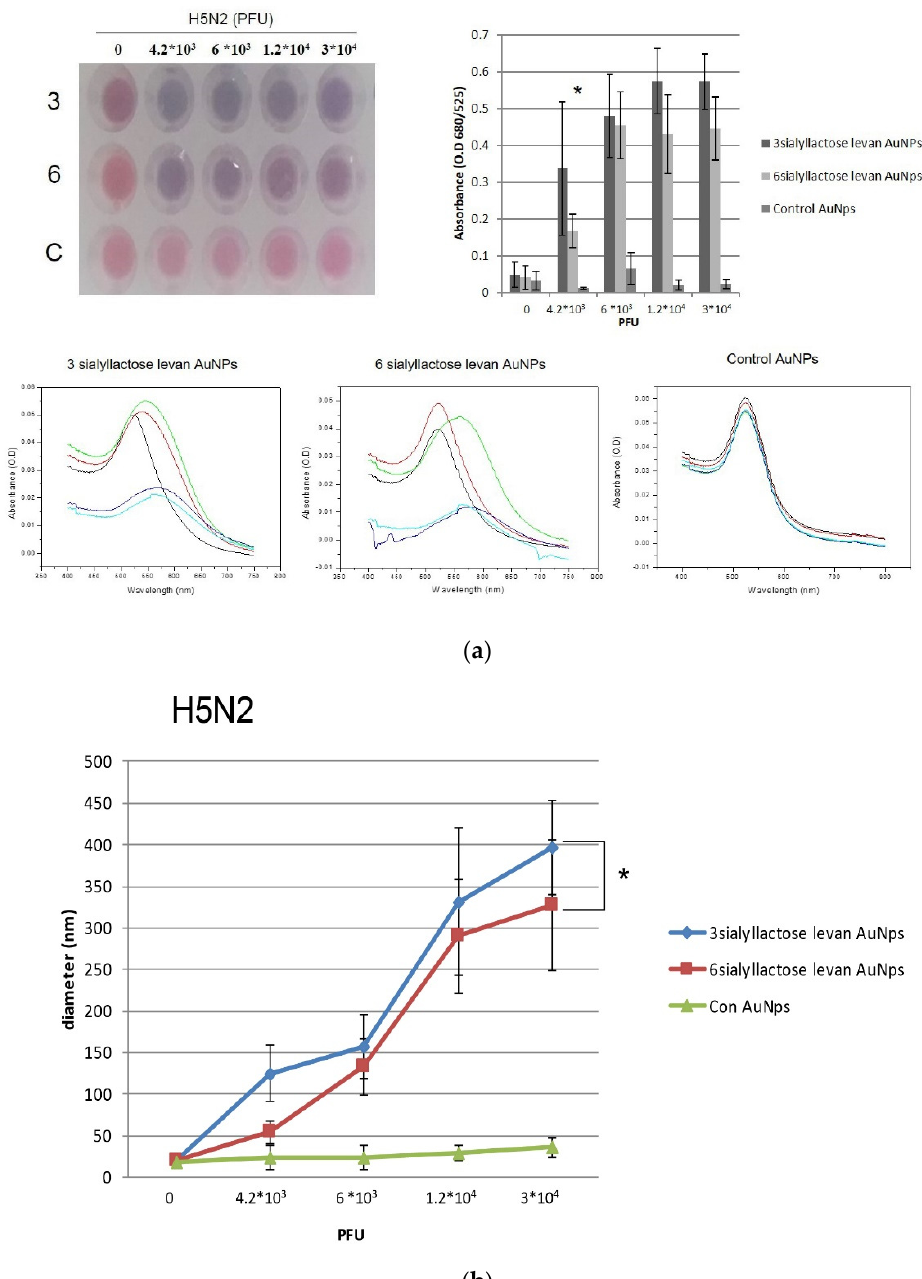
Figure 5. Interaction of AuNPs with Avian H5N2 influenza virus. Colorimetric assay of AuNPs interacting with Avian H5N2 virus ( a ), UV-vis and relative absorbance ratios (Abs 680/Abs 525) (H5N2 virus concentration: black, 0; red, 4.2 × 10 3 pfu; green, 6 × 10 3 pfu; blue, 1.2 × 10 4 pfu; sky blue, 3 × 10 4 pfu). The hydrodynamic diameter of nanoparticles through the reaction between each prepared nanoparticles and each concentration of influenza virus H5N2 as measured using DLS ( b ) (* p < 0.05).